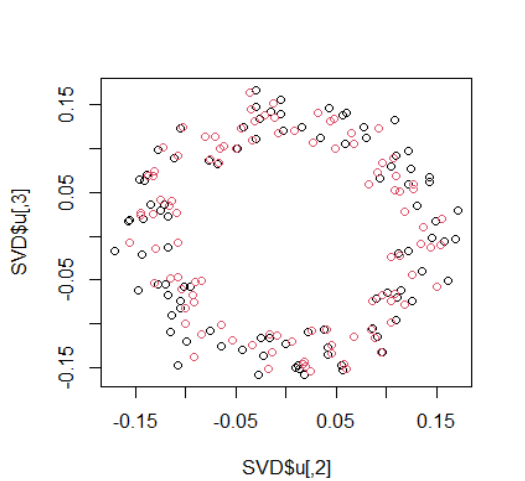
Figure 8. Simulation to identify the eigenvector with the original structure using sample